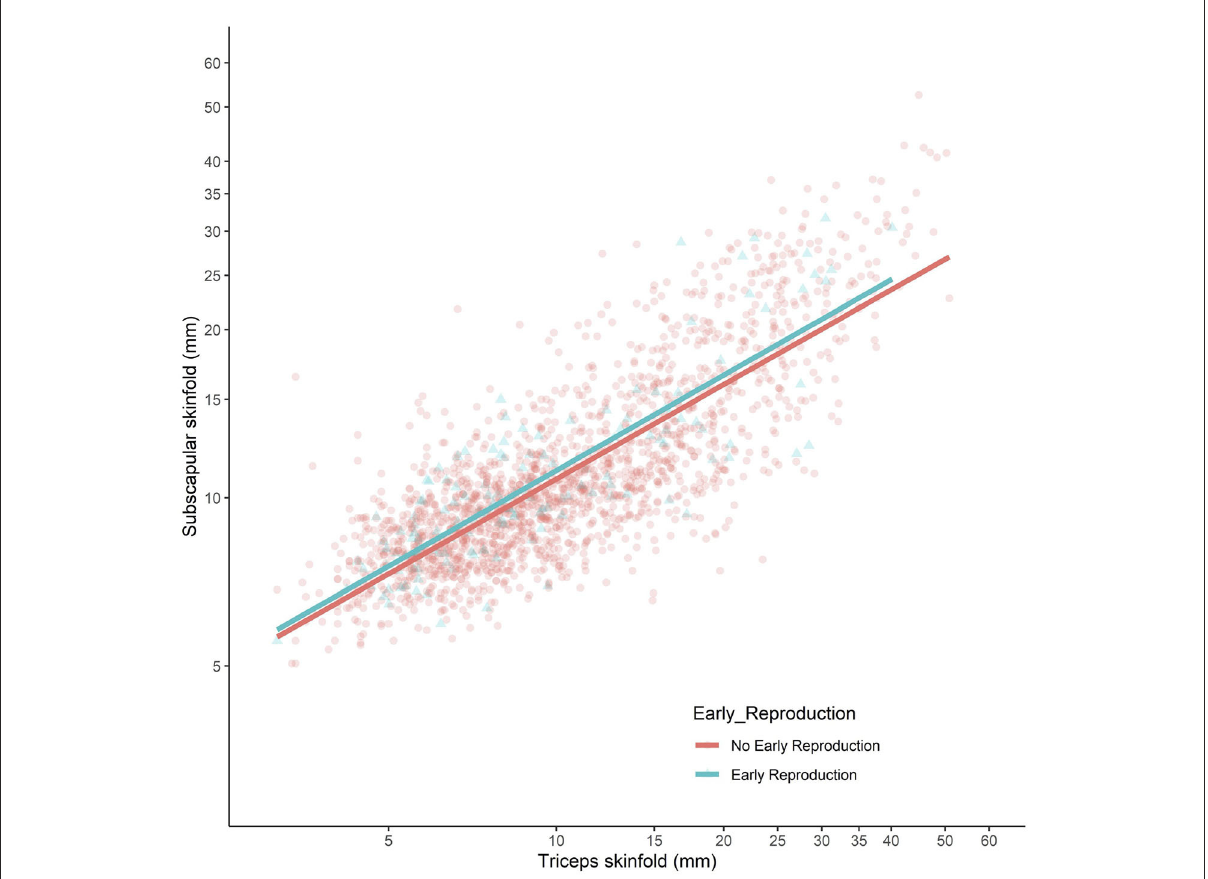
FIGURE3 Subscapular skinfold plotted against triceps skinfold in the adult sons, stratified by whether they had reproduced by 18 years (blue scatter and line) or not (red scatter and line). Both axes present log-scales. Early reproducing sons did not differ in their subscapular skinfold ( 1 = 0.4mm, 95% CI − 0.2, 0.9) for a given triceps skinfold, indicating no difference in central fat deposition.